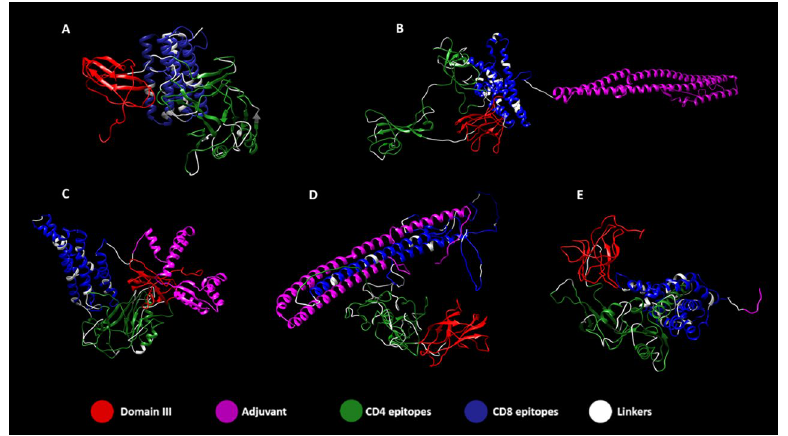
Figure 4. Tertiary structure of ZIKVac ( A ) with highlighted epitopes flanked by linkers and the adjuvants at the C-terminal position, which are the flagellin ( B ), 50S Ribossomal ( C ), Heparin-binding hemagglutinin (HBH) ( D ) and RS09 ( E ). In red is the ZIKV Envelope Domain III, in magenta the adjuvants, in green CD4 epitopes, in blue CD8 epitopes and in white the